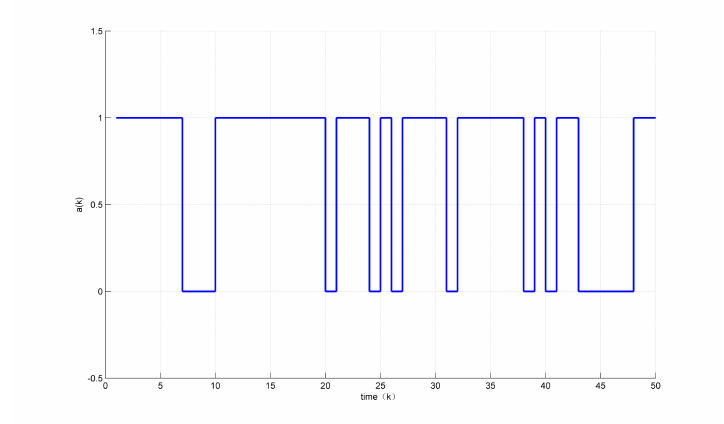
Figure 7. Evolution of